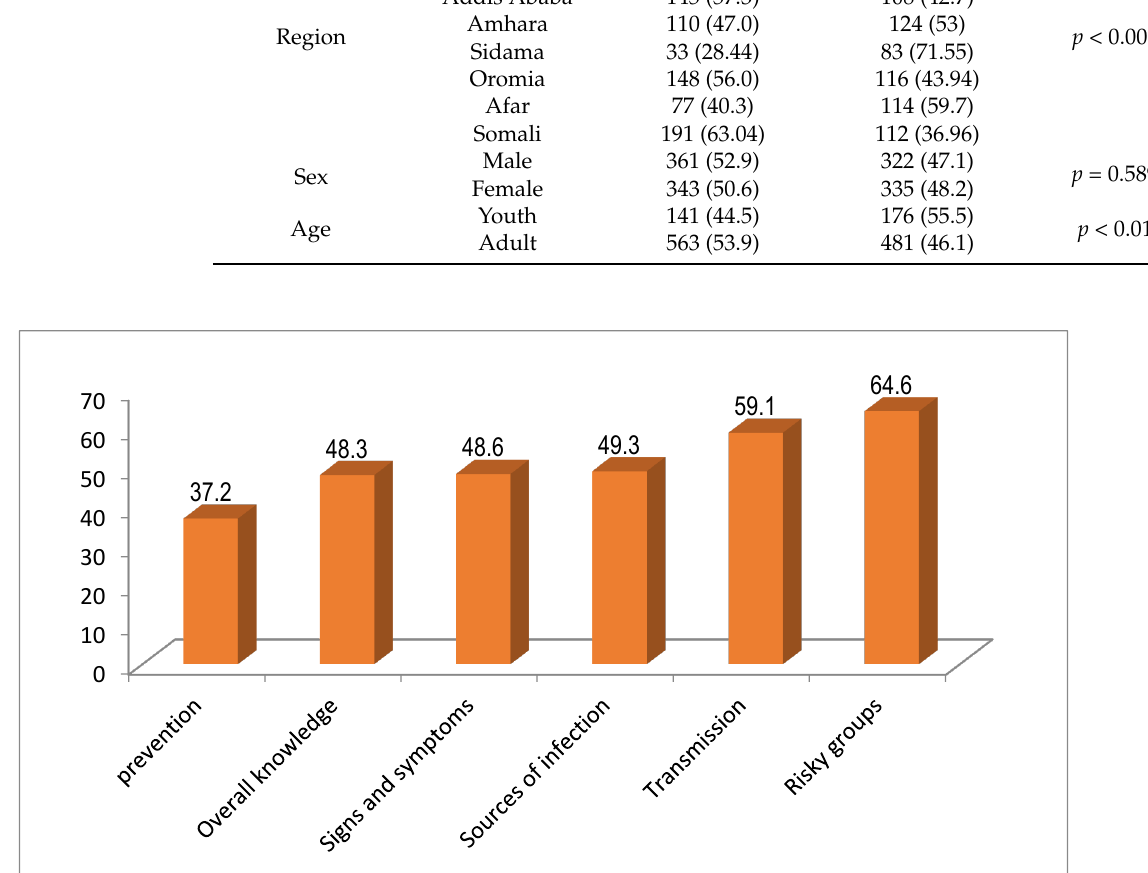
Figure 1. Subcomponents and prevention methods, overall knowledge level, about COVID-19 signs and symptoms, sources of infection, means of transmission, and risky groups at the time of the COVID-19 hesitancy survey, 2022.